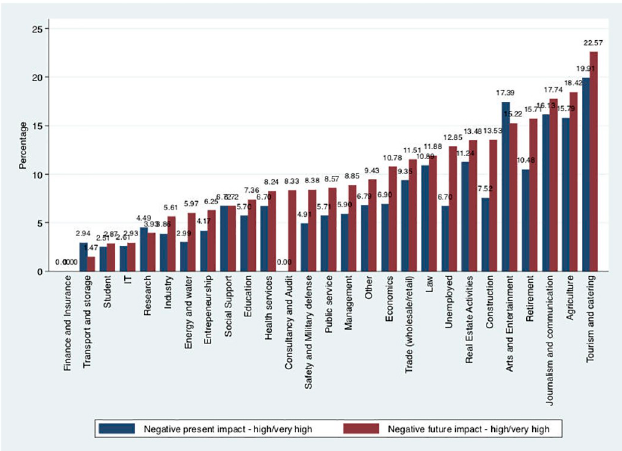
Fig 3. Proportion of respondents feeling present and future negative financial impact of the pandemic.